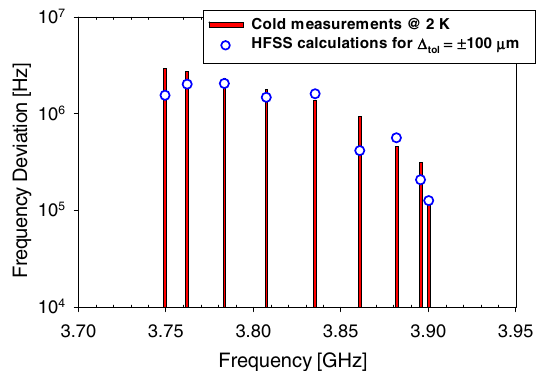
FIG. 9. Frequency standard deviations for the first monopole band of the 3.9 GHz cavity.